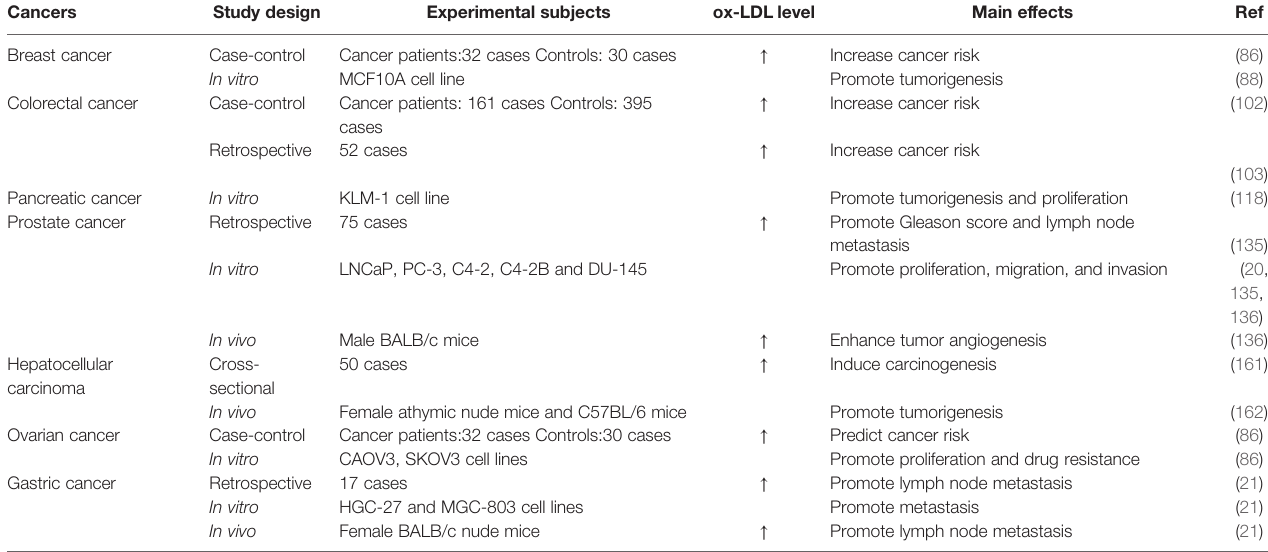
TABLE 2 | LDL levels and their possible effects on the development of selected types of